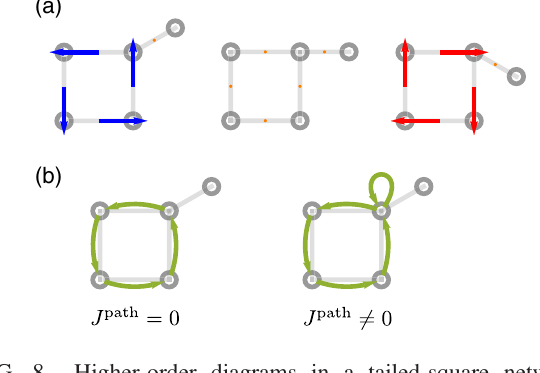
FIG. 8. Higher-order diagrams in a tailed-square network. (a) Direction of the flux can be controlled by the orientation of the side chain. (b) From the diagrammatic approach, the flux of the lowest-order diagram (square) vanishes, and the first non- vanishing diagram is affected by the side